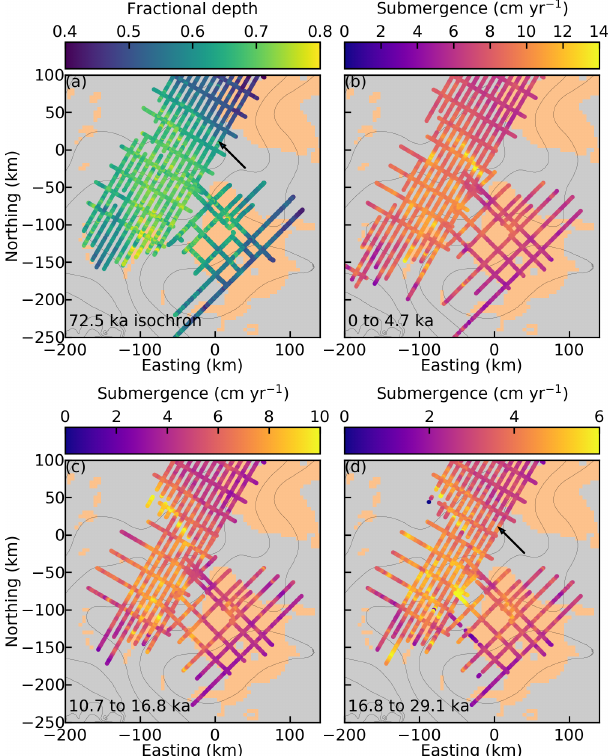
tional depth of the 72.5ka IRH. The submergence panels, (b) , (c) , and (d) , show the submergence calculated between two dated IRHs. The black arrow points to and is aligned with a linear feature that marks a boundary of differential IRH drawdown. Each panel is plot- ted over orange shading, which shows ice core target candidates A and B (Van Liefferinge and Pattyn, 2013), and 100m surface eleva- tion contours (Helm et al., 2014). The dome is surrounded by the 3100m contour. The coordinate system used is polar stereographic